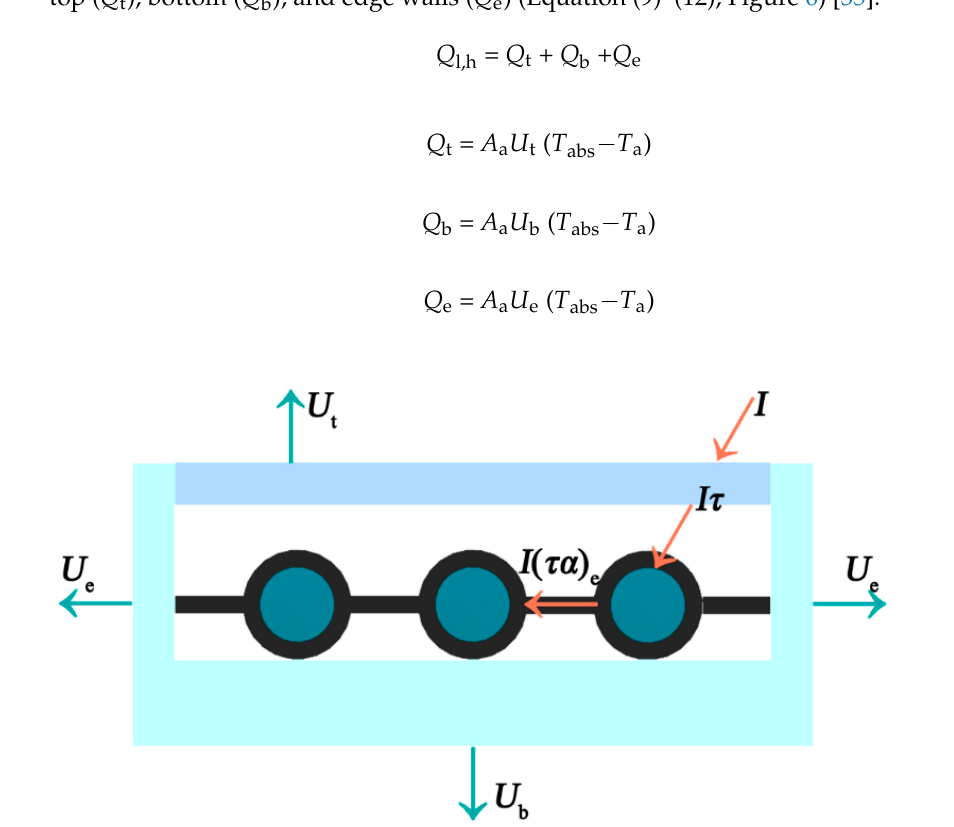
Figure 6. Total heat loss composition of a VTBC solar collector.